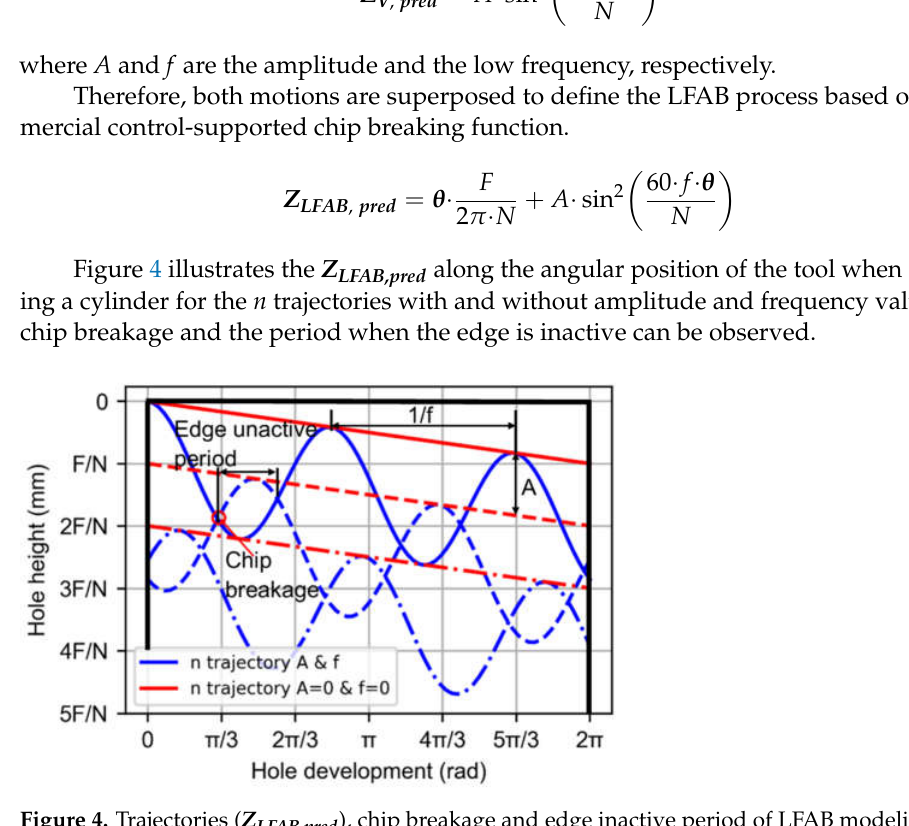
Figure 4. Trajectories ( Z LFAB,pred ), chip breakage and edge inactive period of LFAB modeling.